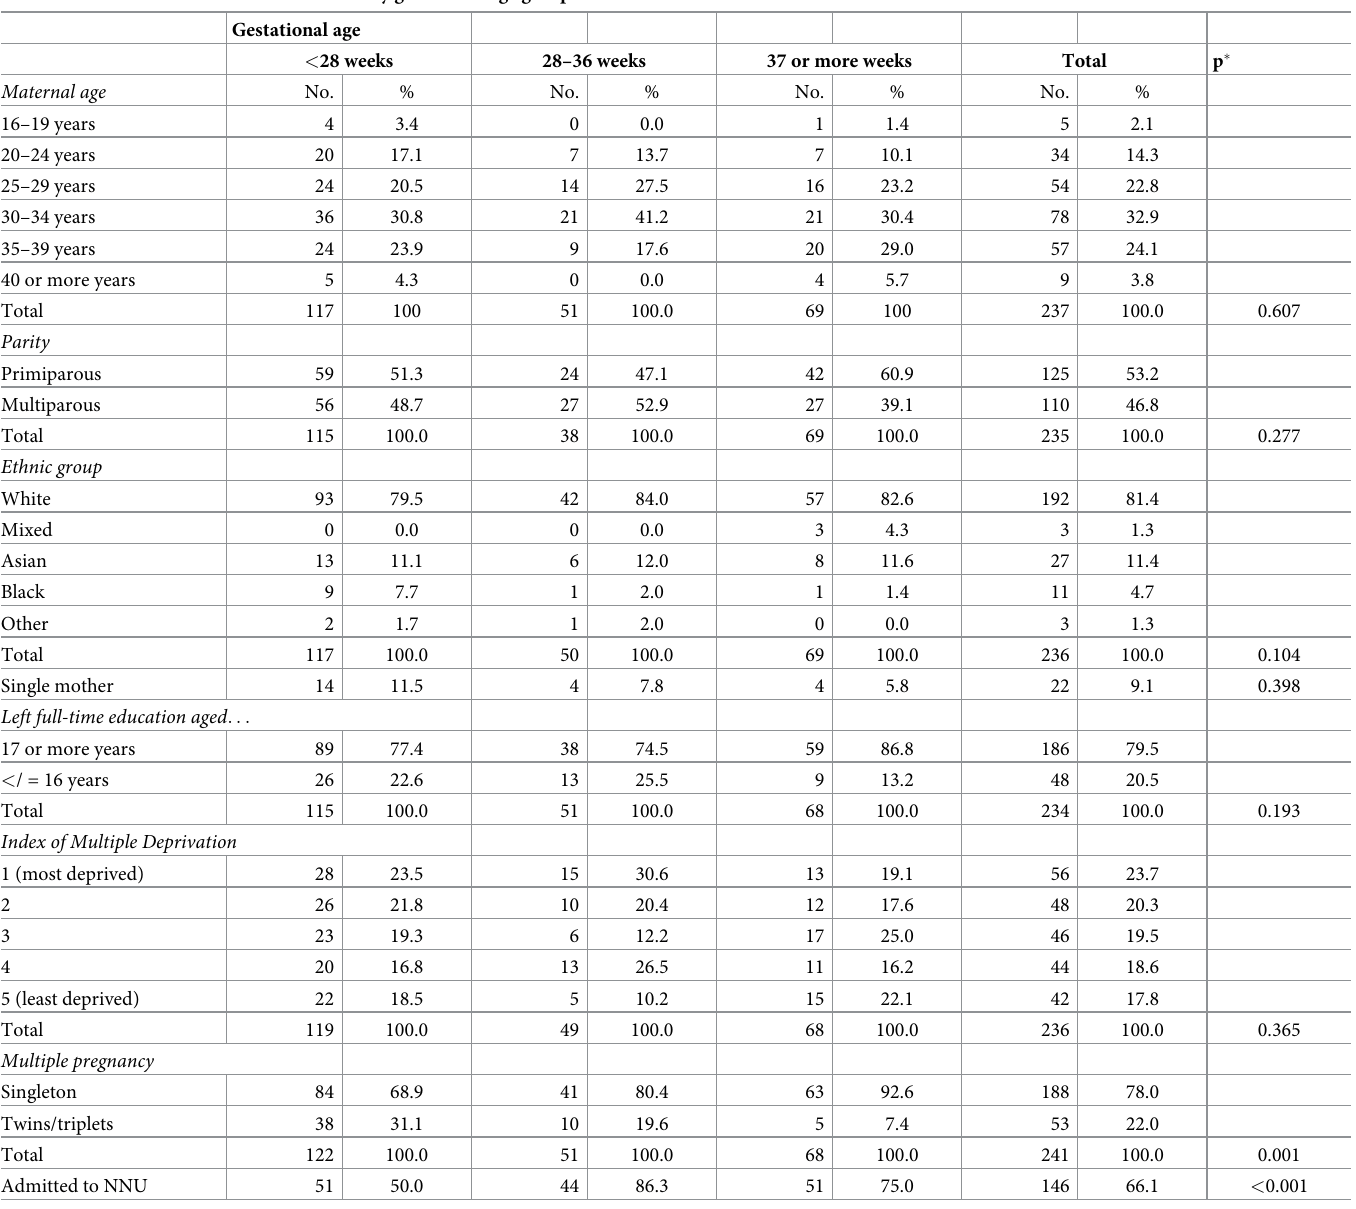
Table 1. Maternal and infant characteristics by gestational age